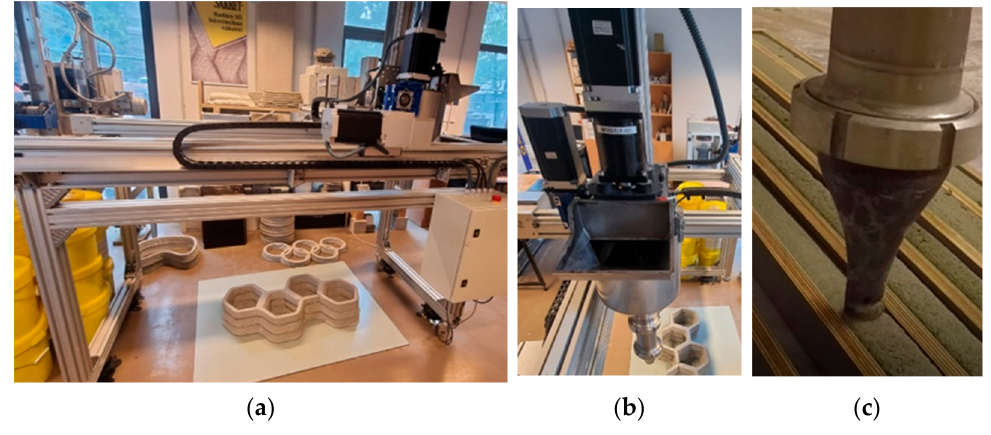
Figure 1. Three-dimensional printer ( a ), printer hopper ( b ), and nozzle ( c ). The mixed concrete was filled into the hopper and extruded through the printhead until a homogenous mass of concrete was flowing through the nozzle. After that, each concrete mixture was printed into pre-prepared molds resembling modified molds for casting concrete samples used in flexural strength tests—height and width of 40 mm and length of 960 mm, printing speed of 800 mm/min. Molds were used to avoid voids caused by layering and to ensure a smooth surface for testing—see Figure 2b. After curing, each molded line was sawed into 6 samples with a length of 160 mm each. The layer height of 10 mm remained the same throughout the printing process—4 layers were printed into the molds creating a model with total height of 40 mm. A total of 12 samples were printed using each concrete mix—see the printed models in Figure 2.